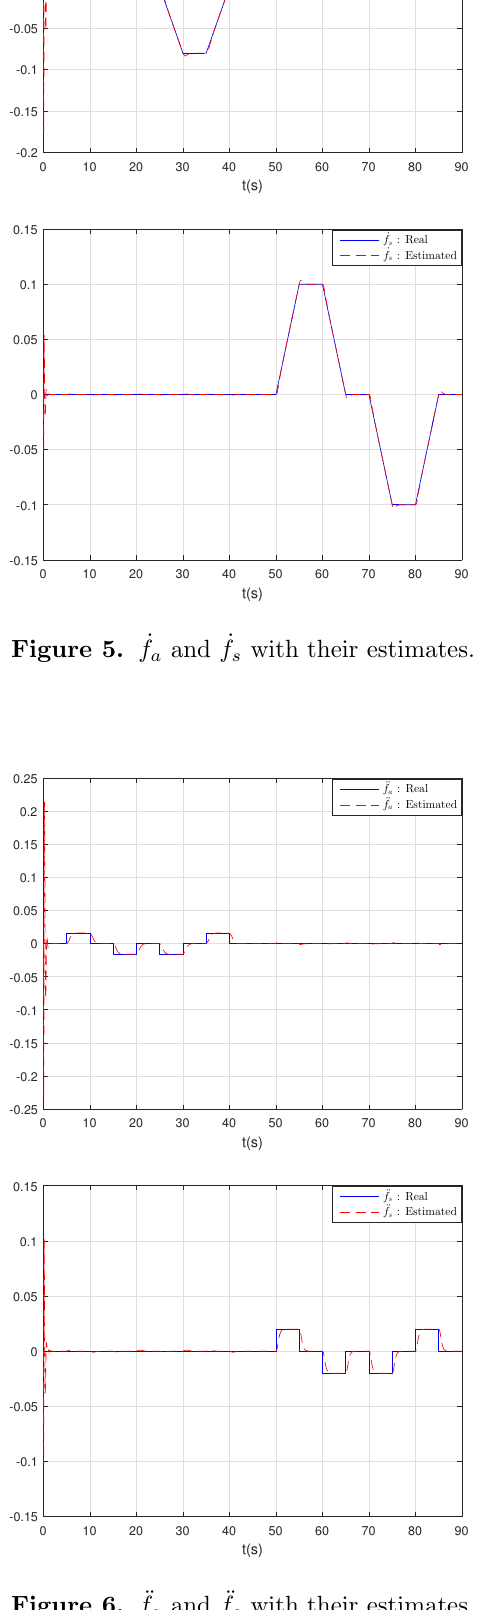
Figure 6. ¨ f a and ¨ f s with their